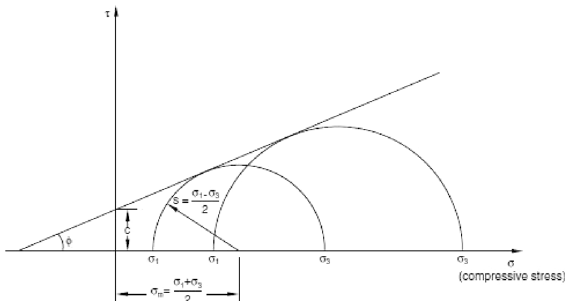
Figure 2. Mohr–Coulomb strength theory.